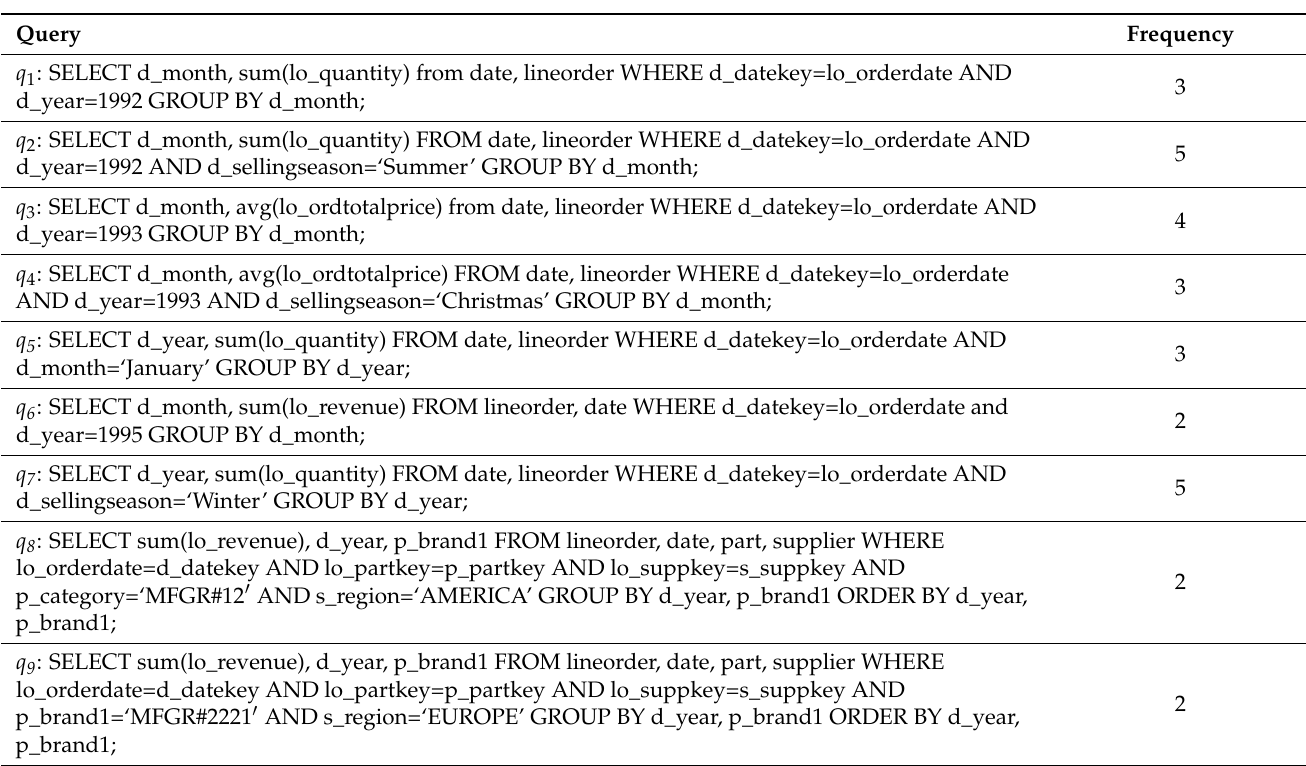
Table 2. Queries executed in